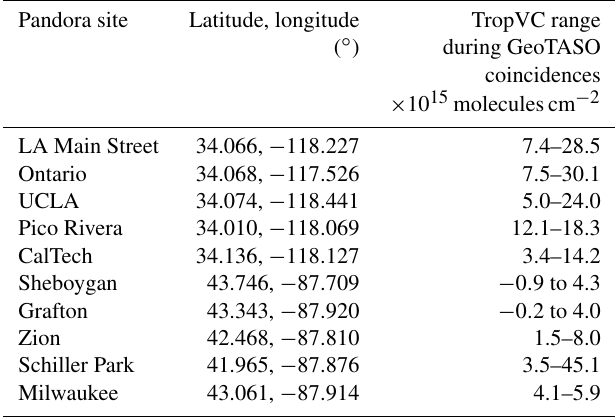
Table 2. Pandora site names, location, and TropVC range dur- ing GeoTASO coincidences in the LMOS and LA Basin domains. These locations are also indicated by hexagons on the maps in Fig. 1. Pandora